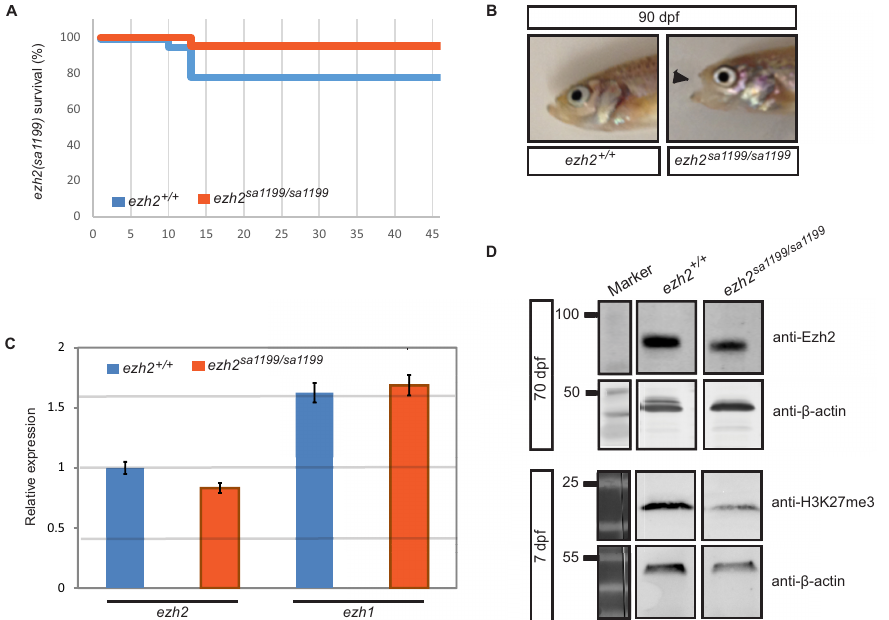
Fig 3. Selectively out-crossed ezh2(sa1199) survives until adulthood. A. Survival graph of ezh2(sa1199) . Survival assay was performed with ezh2(sa1199) in-crossed wild type (N = 18, blue line) and mutant (N = 21, orange line) siblings until 46 dpf. Some larval lethality during raising was seen both in wild types and mutants. The graph indicates that the survival of homozygous ezh2(sa1199) mutants is not significantly different from wild type siblings. B . Pictures of wild type and mutant ezh2(sa1199) adult siblings. While wild types have normal jaws (left), adult ezh2(sa1199) mutants (right) display an open mouth phenotype (black arrowhead). C. RT-qPCR measurement of ezh1 and ezh2 mRNA in ezh2(sa1199) adults. The (decapitated) body of 70 dpf wild type (blue) and mutant (orange) individuals were lysed and the presence of ezh1 and ezh2 mRNA was quantified and normalized to the reference genes ß-actin and ef1a . The ezh1 (p = 0.9509) and ezh2 (p = 0.1493) mRNA levels were not significantly altered in mutants. D. Ezh2 protein in single 70 dpf adults and H3K27me3 in 7 dpf pooled larvae. The presence of Ezh2 was tested in wild type (N = 3, left) and mutant (N = 4, right) bodies at 70 dpf, where Ezh2 expression persists (upper panel). At 7 dpf, mutant larvae (right) show 41.8% decreased levels of the H3K27me3 mark compared to wild type (left) larvae (lower panel) and relative to β -actin loading control. For each Western blot, representative bands were cropped from the same blot and shown in boxes for clarity of